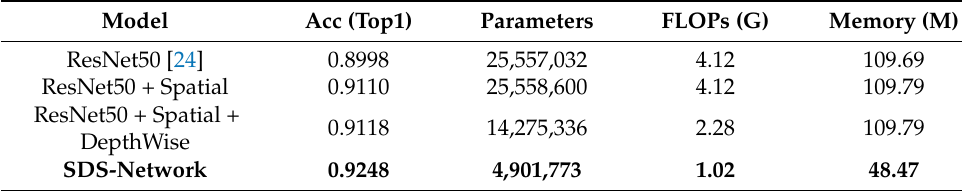
Table 3. Comparison of data performance between SDS-Network and